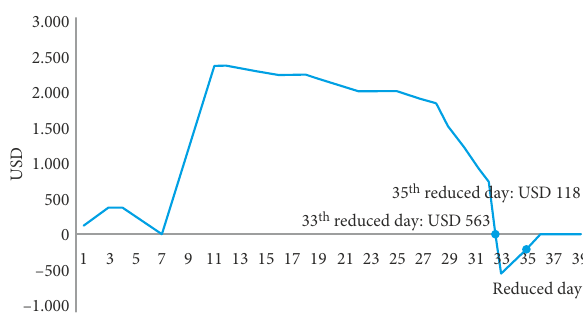
Figure 6. The comparison between the proposed and cost slope